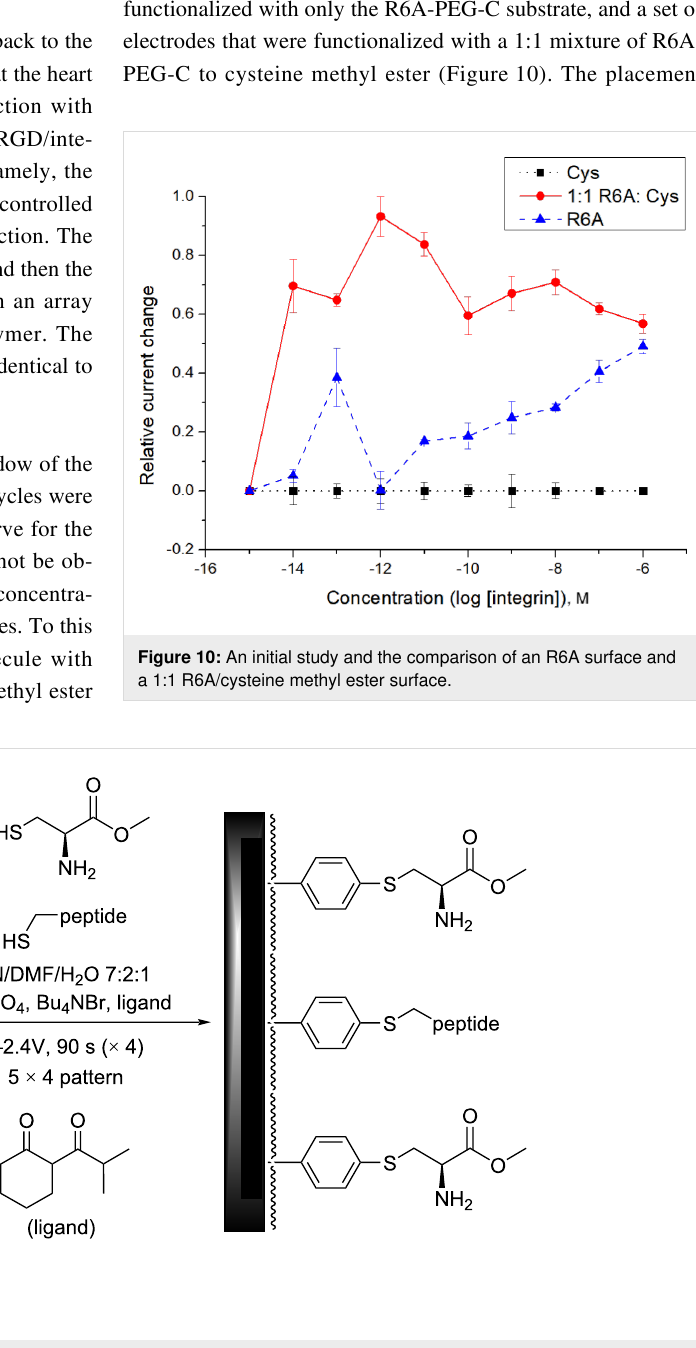
Scheme 3: A new method for decreasing the concentration of R6A on the surface of the electrodes.